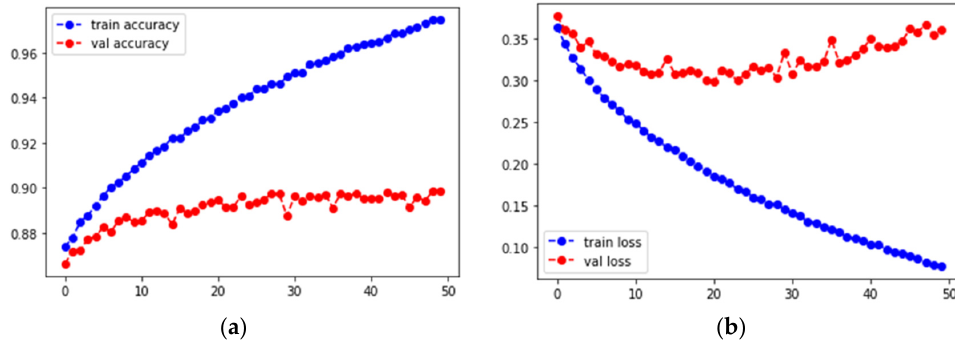
Figure 18. Training and testing of MLP + HPO model: ( a ) training and validation accuracy, ( b ) training and validation loss.